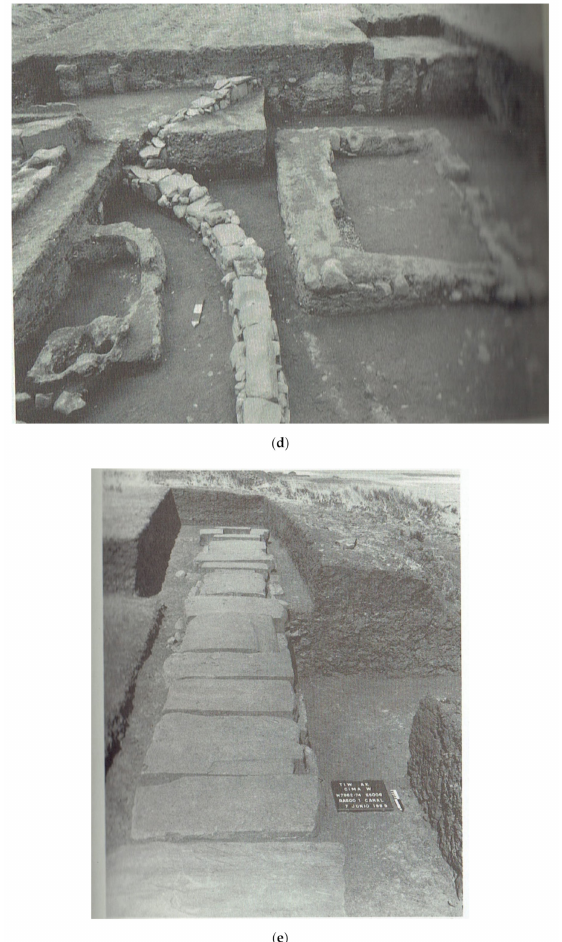
Figure 1. ( a ) Representative FLOW-3D Computational Fluid Dynamics (CFD) model of hydrological and architectural features of the Tiwanaku ceremonial center. The CFD model is a best-estimate representation of the site geometry scaled from aerial photos, historical sources and ground survey. Line a–b represents a later drainage path interpretation compared to earlier curved versions by Poznansky 1945 and Bandelier 1911 used for the model. The A’-B’ channel represents the Tiwanaku River. ( b ) Schematic of several main ceremonial sites within the perimeter drainage channel; P and Q represent subterranean drainage channels under the Putuni’s palace floor. The perimeter drainage channel surrounds this area (Figure 1a). ( c ) Excavated P subterranean channel section located below the Putini floor- note scale from Figure1. ( d ) Two top-slab excavated canals below floor level at La Karaña leading water to subterranean channels P and Q. ( e ) Slab-covered channel originating from the top platform of the Akapana and running at high slope down the side of the Akapana pyramid to drain the room complex located on the top